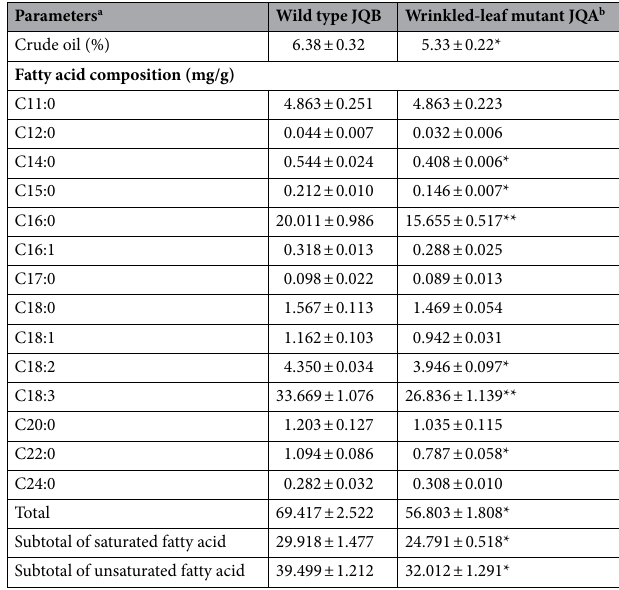
Table 1. Crude oil content and fatty acid compositions in sesame leaves. a The details of fatty acid compositions can be found in Fig. 1. b Values are means ± standard deviation for n = 3. Data in the same row followed by different letters are significantly different ( p < 0.05). Data in the same row followed by * and ** are significantly ( p < 0.05) and very significant ( p < 0.01) different,